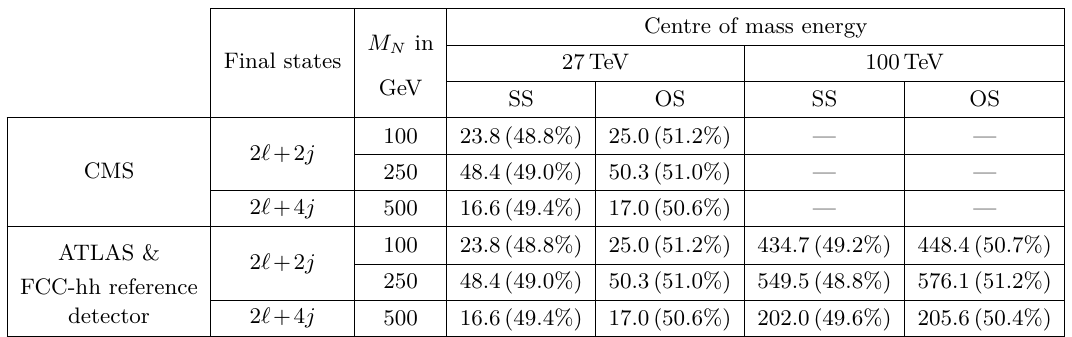
Table 17. Number of events containing SSD or OSD and their percentage numbers (in bracket) for different RHN masses ( M in GeV) with the centre of mass energies of 27, 100 TeV, at the N integrated luminosities of 10 , 30 ab − 1 , respectively, considering the root sum square values of the Yukawa couplings discussed in subsection 3.1.